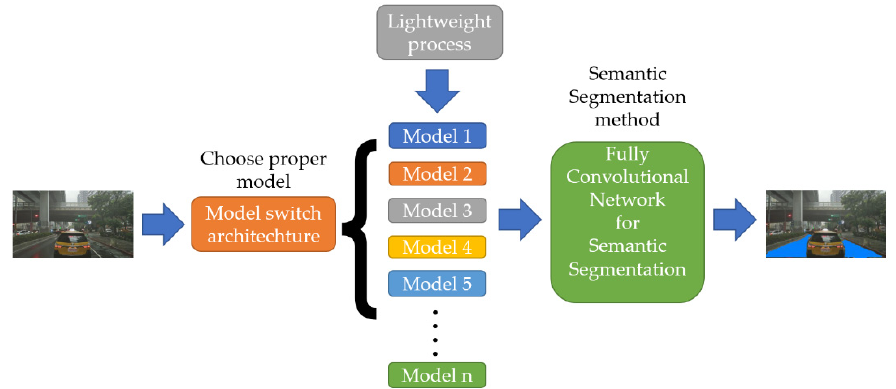
Figure 1. Proposed convolutional network with model ‐ switching architecture and lightweight processes.